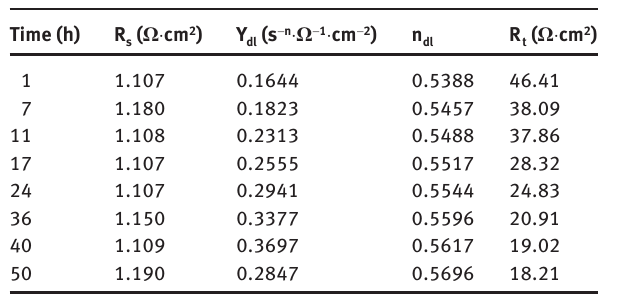
Table 2: Fitting results of electrochemical impedance spectra for the corrosion of pure iron in molten (Li,Na,K)F at 973 K